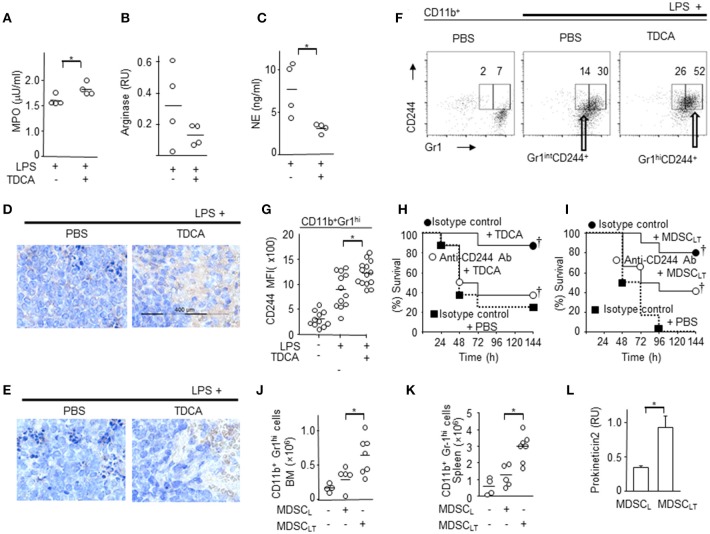
Potential molecular mediators of CD11b+Gr1+ cells for immune regulatory function. CD11b+Gr1hi cells were purified from the spleen and enzyme activity or level of transcripts were determined. (A) MPO enzyme activity. (B) RT-PCR analysis of arginase gene. (C) NE enzyme activity. DATA pooled from 2 independent experiments for A~C. Representative oncostain M (D) and lactoferrin (E) expression in splenocytes from septic mice determined by immunohistochemistry after treatment with PBS or TDCA. Data shown are representative of 3 independent experiments with 3 samples per experiment. (F) Representative FACS plots of (G) indicating the surface expression of CD244 on splenic CD11b+ Gr1hi cells. The gating strategies are shown in Figure S15. (G) MFIs of CD244 expression on CD11b+Gr1hi cells are plotted. Data pooled from 4 independent experiments with 2~4 samples per experiment. (H) Survival rate of septic mice given LPS i.p. after recieving isotype control antibody + TDCA (•), anti-CD244 antibody + TDCA (°), or isotype control antibody + PBS (■). n = 8 (I) Survival rate of septic mice that received LPS i.p. after being administered isotype control antibody + adoptive transfer of MDSCLT (•, n = 10), anti-CD244 antibody + adoptive transfer of MDSCLT (°, n = 12), or isotype control antibody + PBS (■, n = 10). The number of CD11b+Gr1hi cells in the bone marrow (J) or spleen (K) after adoptive transfer of MDSCL or MDSCLT. The number of total BM cells or total splenocytes were counted and the number of CD11b+Gr1hi cells was calculated using the % of cells after FACS analysis as in Figure 2E. (L) RT-PCR analysis of prokineticin 2. n = 4, RU, relative units of band intensity normalized to the intensity of GAPDH. Short horizontal lines among the circles indicate the mean values. *p < 0.05 by the Student's two-tailed t-test. p < 0.05 using Kaplan-Meier survival analysis and the log-rank test between groups with the same symbol. Data shown are pooled from 3 independent experiments with 1~4 samples per experiment otherwise denoted.